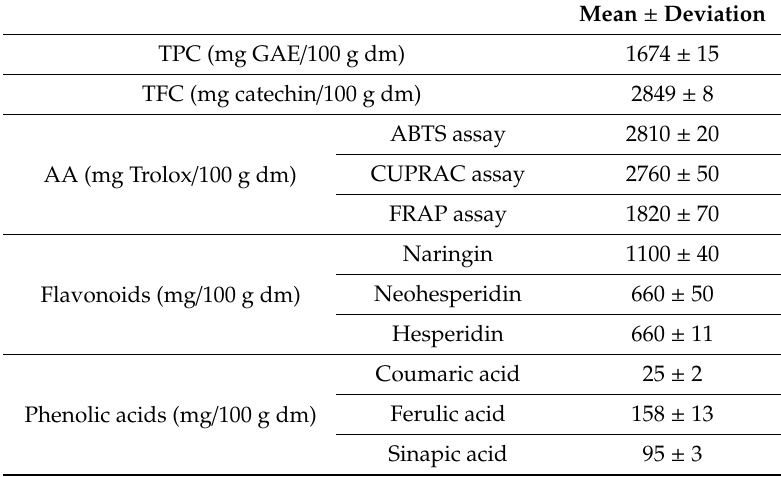
Table 1. Total polyphenol (TPC) and flavonoid (TFC) contents, antioxidant activity (AA) (ABTS (2.2 (cid:48) -azino-bis(3-ethylbenzothiazoline-6-sulfonic acid), CUPRAC (cupric reducing antioxidant capacity), and FRAP (ferric reducing antioxidant power) assays) and contents of main flavonoids and phenolic acids of initial orange byproduct before extraction. Means and